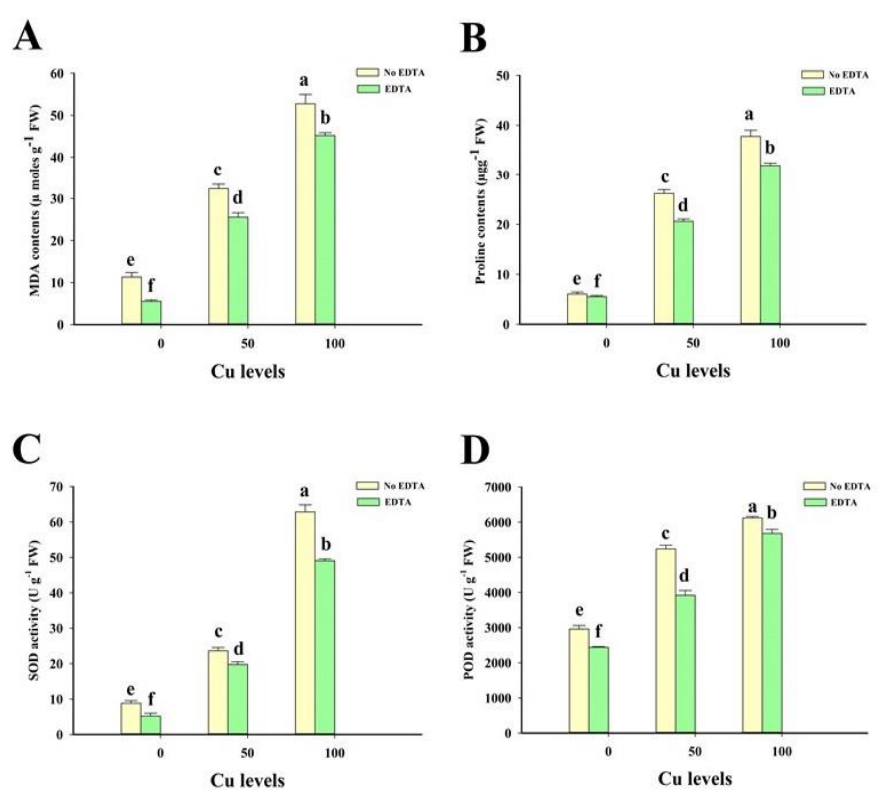
Figure 3. Effect of different concentrations of Cu with or without the application of EDTA on malondialdehyde contents ( A ), proline contents ( B ), superoxidase activity ( C ) and peroxidase activity ( D ) in the leaves of C. capsularis seedlings grown in solution medium with increasing Cu concentrations (0, 50 and 100 μM) treated with and without 3-mM EDTA. The given values are means ±SD (n = 3). One-way ANOVA was performed and means differences were tested by highest significant difference HSD ( P < 0.05). Different lowercase letters in figure indicate significant difference between the treatments.